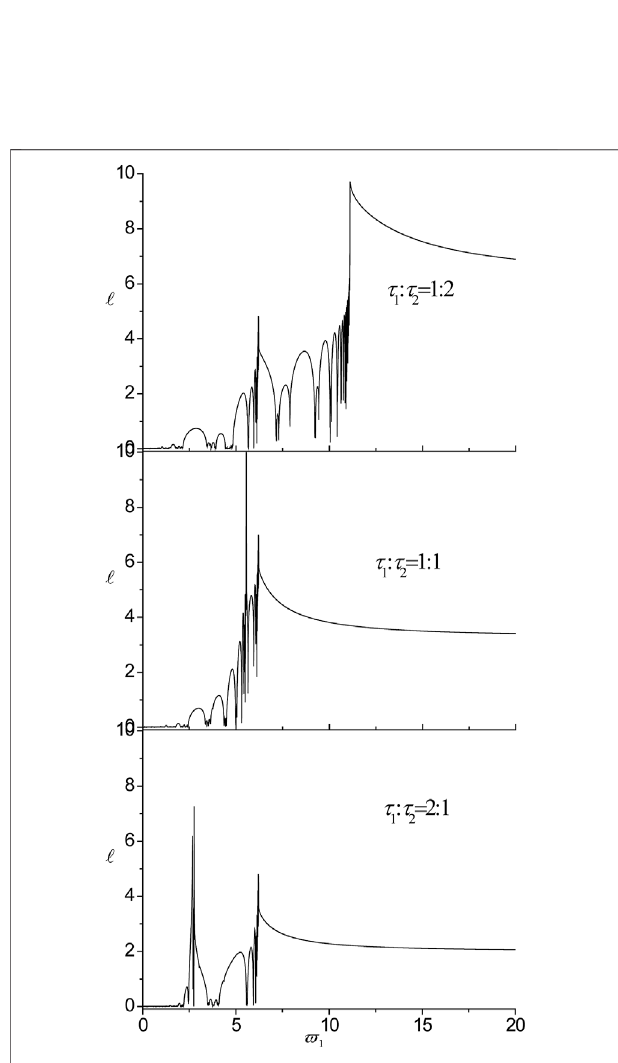
FIGURE 14 | The in fl uences of the ratio of the internal characteristic length on localization factors in the nanoscale Fibonacci systems consisting on Cu/Al for l 1 = l 2 =